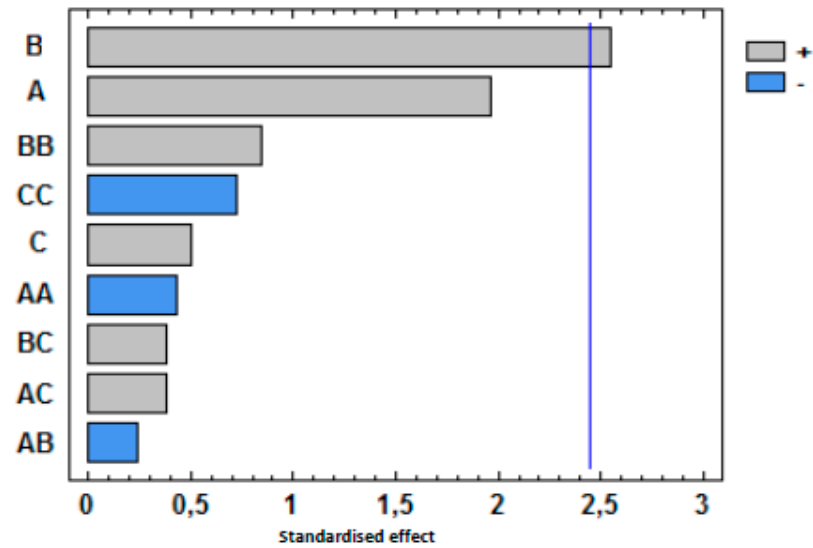
Figure 4. Pareto charts of factors and interactions obtained from the BBD for the sum of the volatile compounds. The vertical line indicates the statistical significance at 5% of the effects.